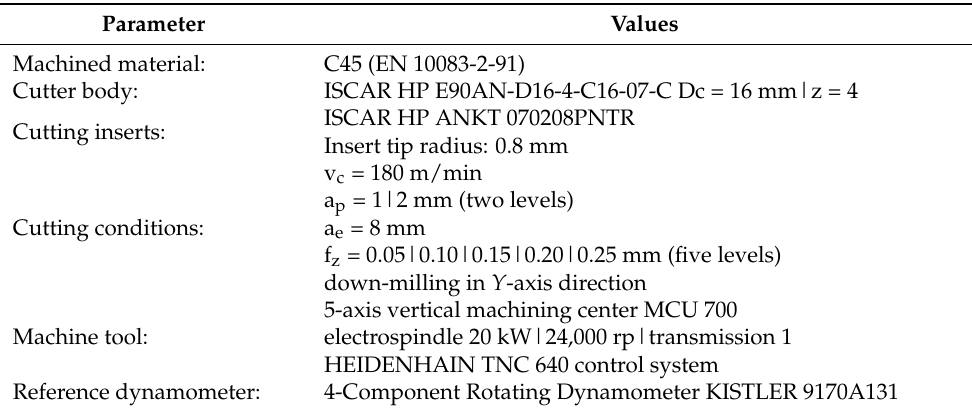
Table 5. Parameters of Case study